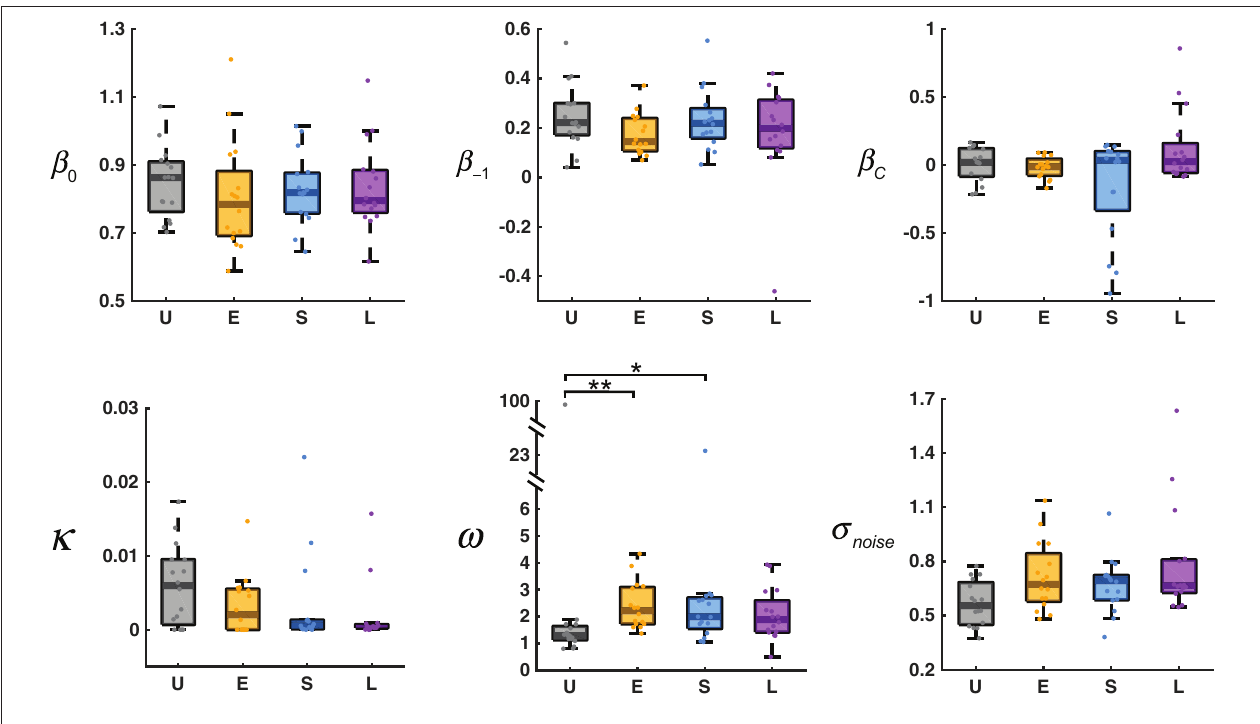
FIGURE 6 | Estimated parameters for the AL-NL model. In the box plot, the middle line denotes the median estimate across participants, the bottom and top lines denote the lower and upper quartiles, and the error bars denote the 99% confidence interval. U, E, S, L denote the four distribution conditions. Dots denote estimates for individual participants. See Table 1 for the references of the parameters ( β 0 , β 1 , β C , κ , ω , σ noise ). *0.01 ≤ P < 0.05. **0.001 ≤ P < −